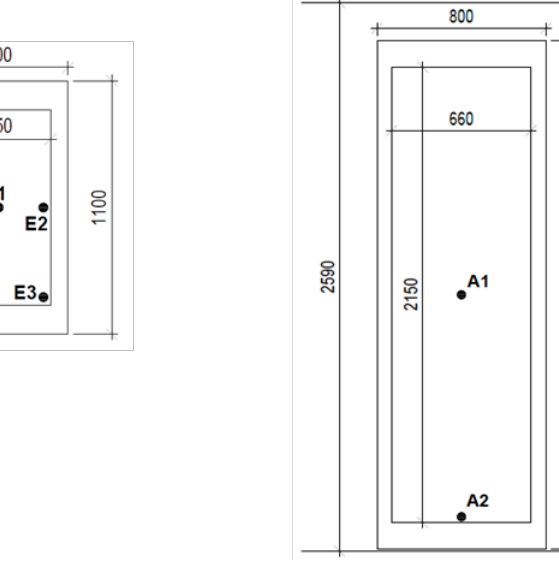
Figure A1. Schematic of a roof window ( left ) and a glazed balcony door ( right ). Points A1, A2, E1,